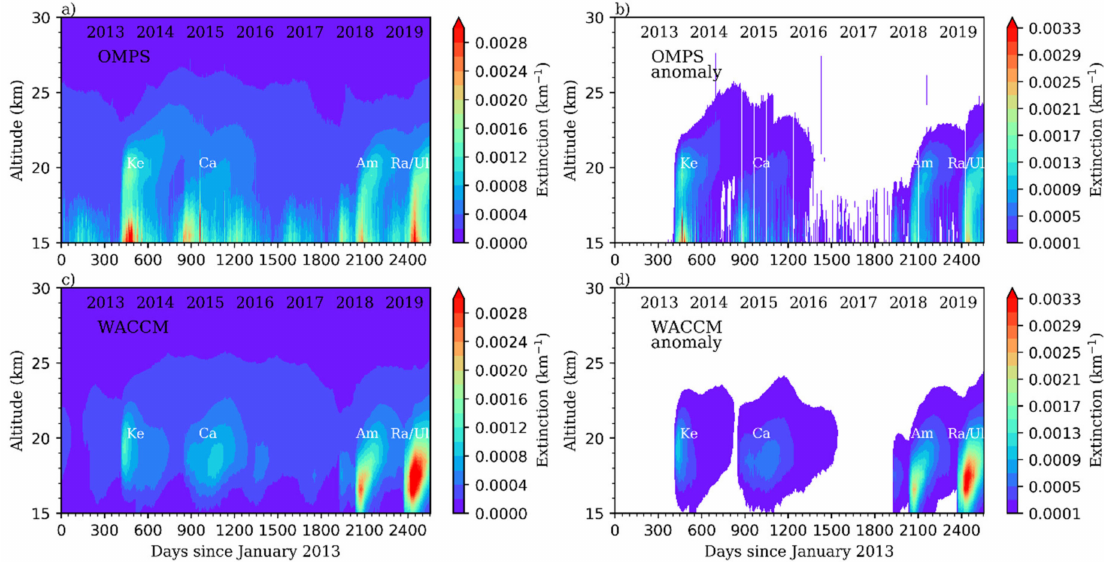
Figure 2. Daily- and zonally averaged extinction (left) as observed by OMPS ( a ) and simulated by WACCM-CARMA ( c ) at 675 nm from 2013 to 2019 in the tropical band (20 ◦ S–20 ◦ N). Model outputs are taken from the volcano-on simulation. Extinction anomalies are calculated with respect to the 2013 volcanically quiescent year for the stratosphere for OMPS ( b ) are derived from the difference between the volcano-on and the volcano-off simulations for WACCM-CARMA ( d ). Volcanic plumes of Kelud, Calbuco, Ambae and Ulawun/Raikoke are denoted by Ke, Ca, Am, Ra/Ul